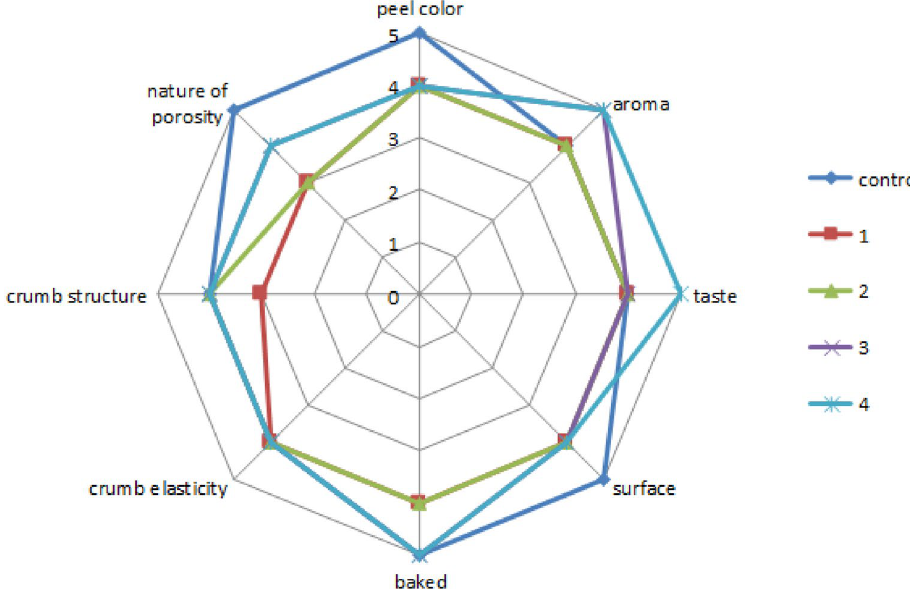
Figure 2. Organoleptic indicators of samples 1–4 in comparison with the control.